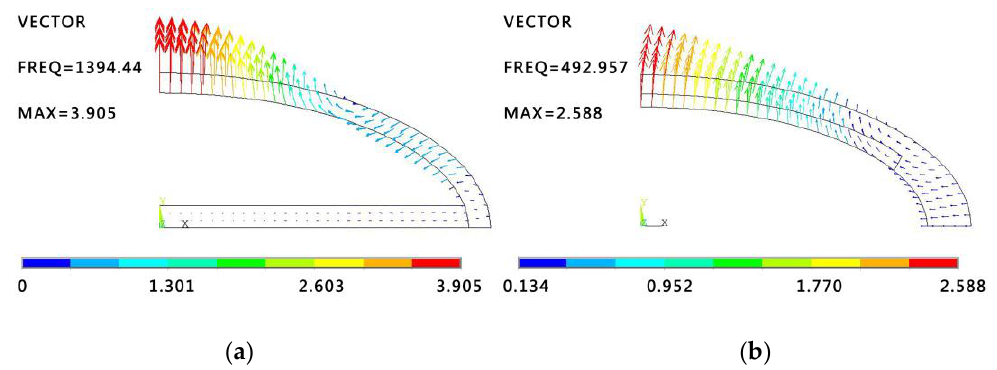
Figure 2. ( a ) The first flexural vibration mode shapes of conventional driving Class IV FT; ( b ) The first flexural vibration mode shapes of conformal driving Class IV FT.